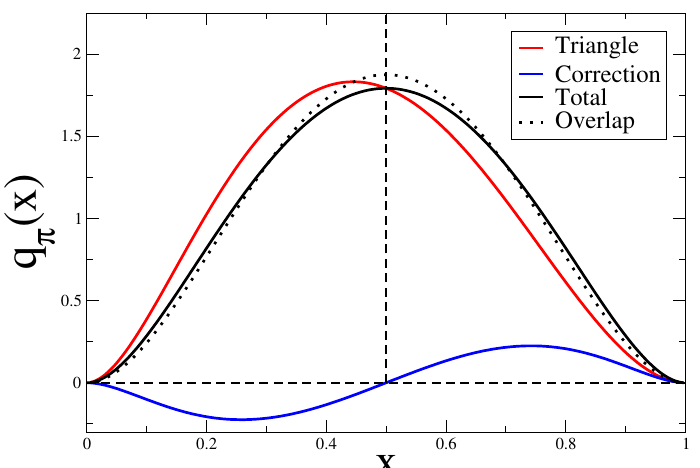
Figure 9. Results for the forward limit after reconstruction of the x -dependence in the case of a simple, algebraic model (see [42,113,114]). The total PDF (solid black) is symmetric under x transformation, but the sole triangle diagram contribution (solid red) is not. The additional terms coming from the square vertices in Equation (70) provide the adequate correction (solid